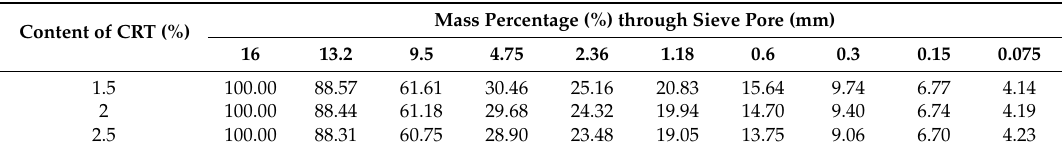
Table 12. Gradation of mixtures under different CRT contents.